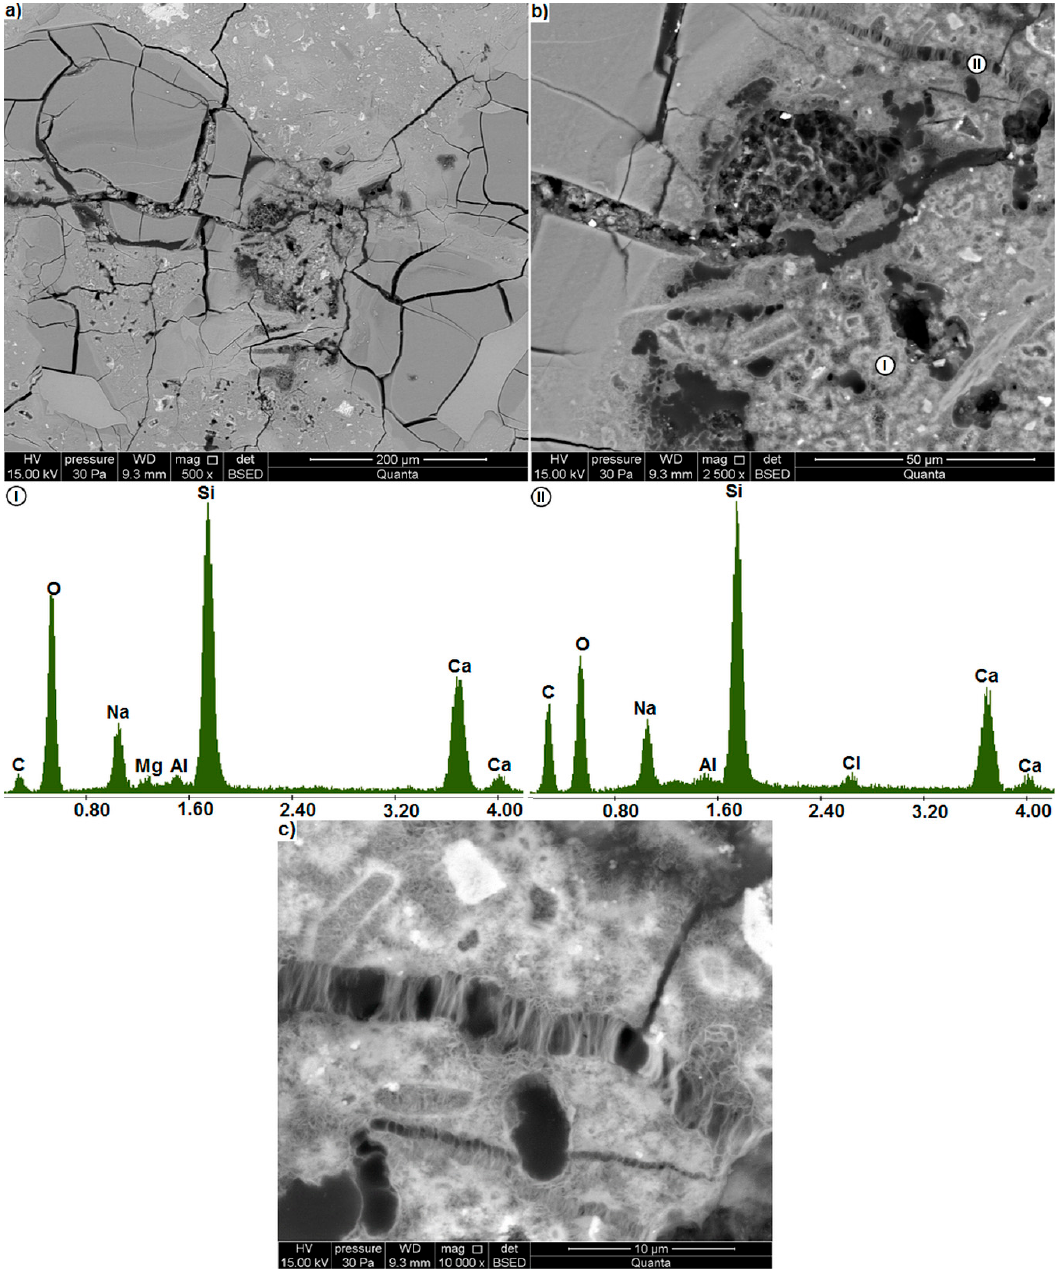
Figure 9. ( a ) extensively cracked region in the microstructure of the mortar containing waste glass ( b ) region of porous gel (BSE); EDS analysis at points I and II, ( c ) cracks in the gel.